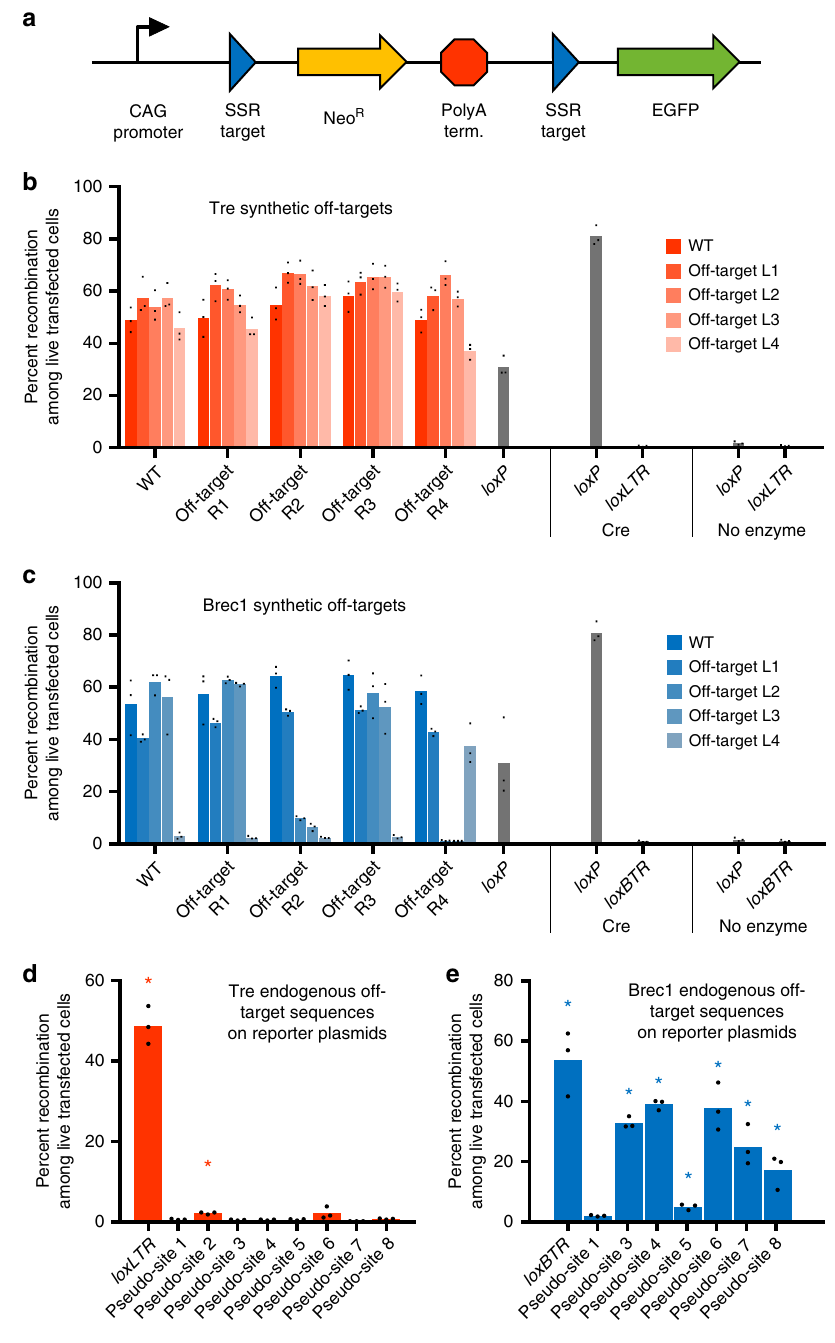
NATURE COMMUNICATIONS| (2019) 10:3003